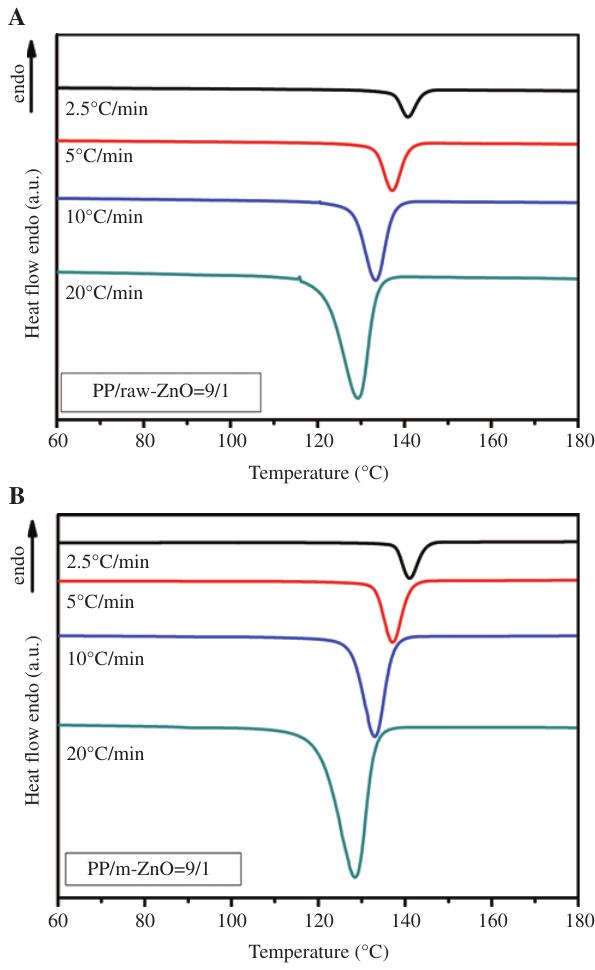
Figure 1 DSC thermograms of non-isothermal crystallization of PP/ ZnO composites at the indicated cooling rates; (A) PP/raw-ZnO and (B)